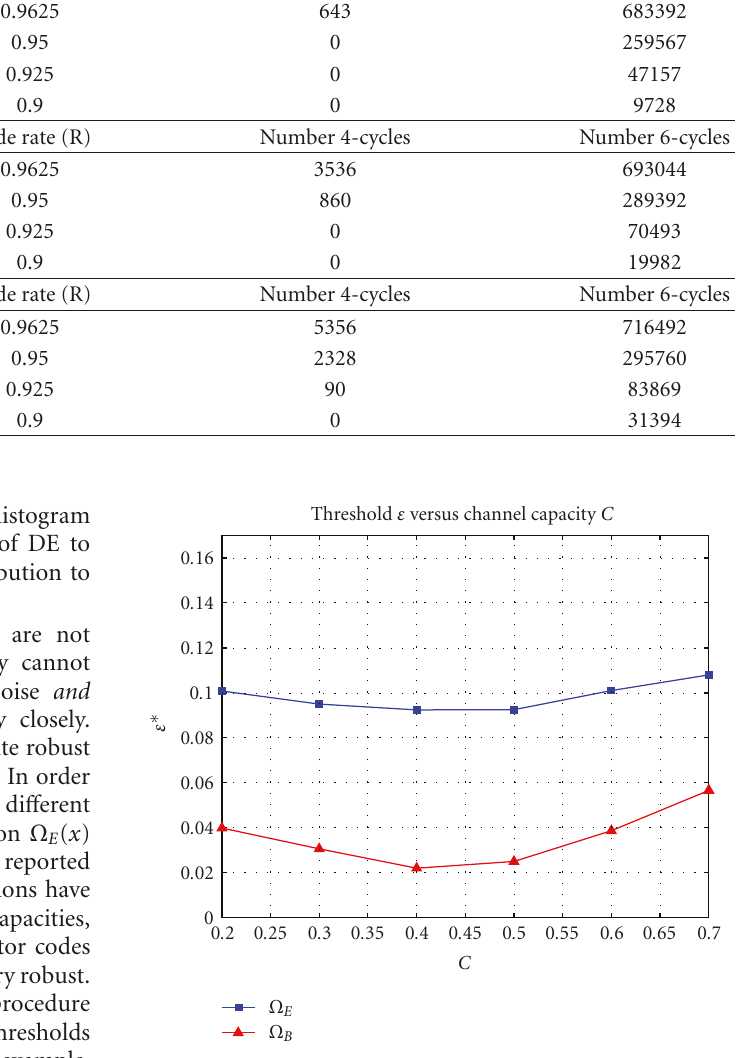
Figure 5: Thresholds of two distributions optimized for C = 0 . 5, for di ff erent channel capacities. We compare Ω B ( x ), a distribution that we optimized for joint decoding, to Ω E ( x ) proposed in [5] decoded under joint